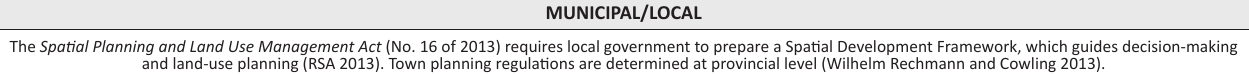
FIGURE 3: The framework within which environmental departments fulfil their mandates to protect biodiversity and ecosystem services, which is guided by policies and legislation which arise from the Constitution, 1996 and inform national and provincial legislation.